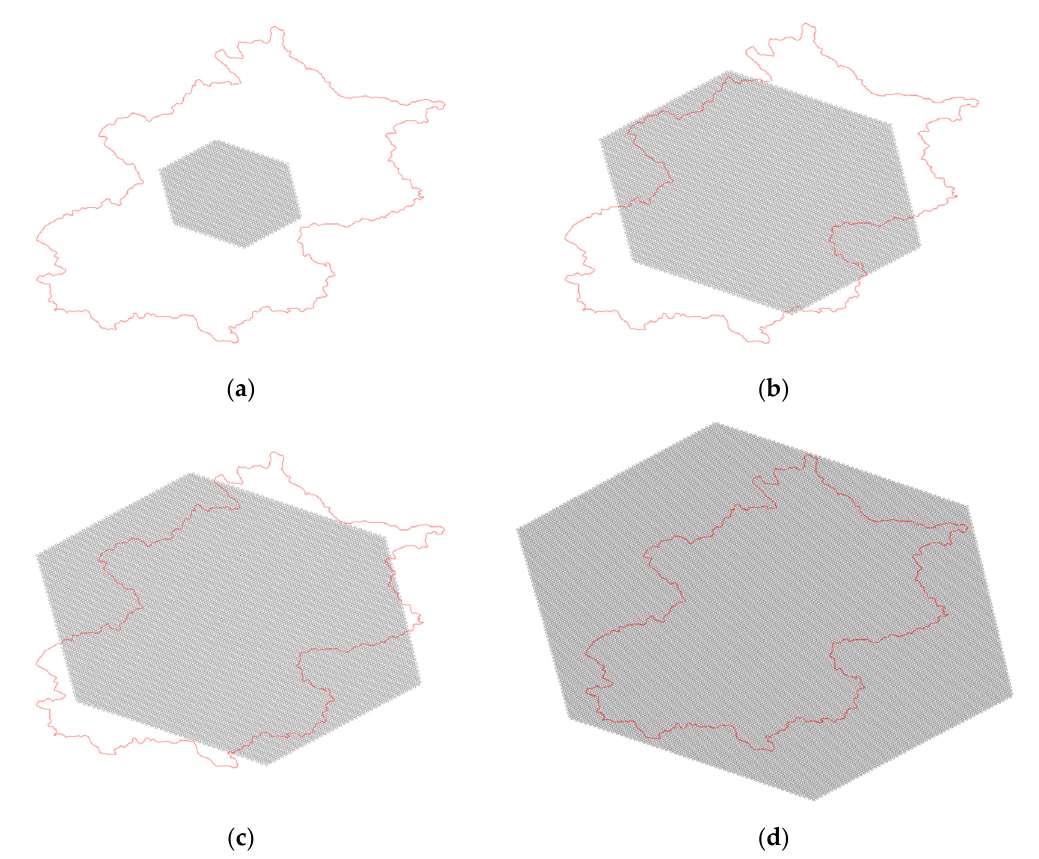
Figure 6. Code indexing results at different times in Beijing (t4 > t3 > t2 > t1): ( a ) indexing result at time t1. ( b ) indexing result at time t2, ( c ) indexing result at time t3, and ( d ) indexing result at time t4.